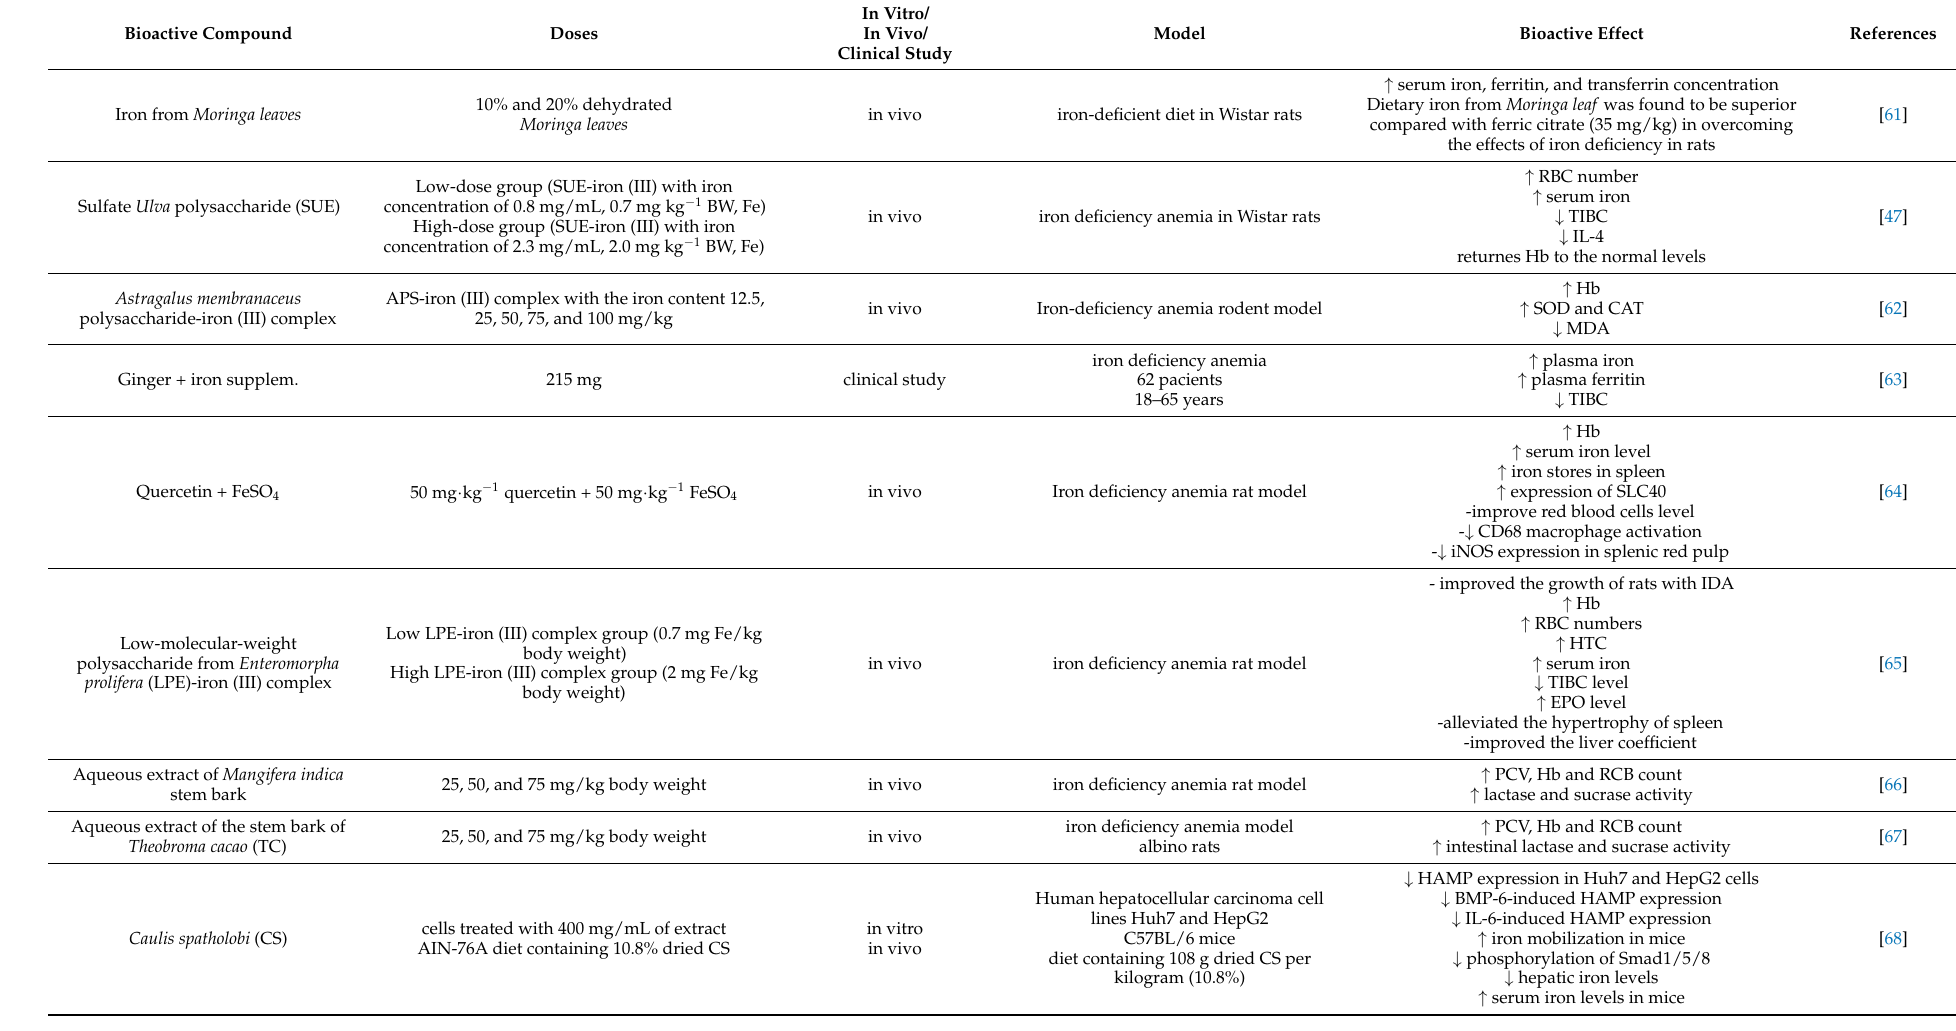
Table 1. Pharmacological effects of natural antioxidants in iron deficiency